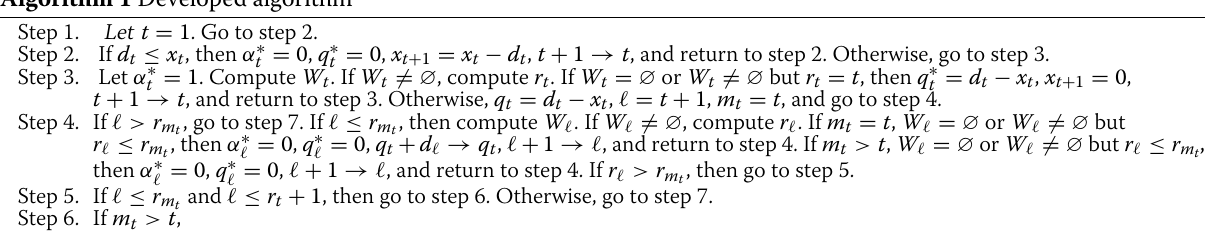
Algorithm 1 Developed